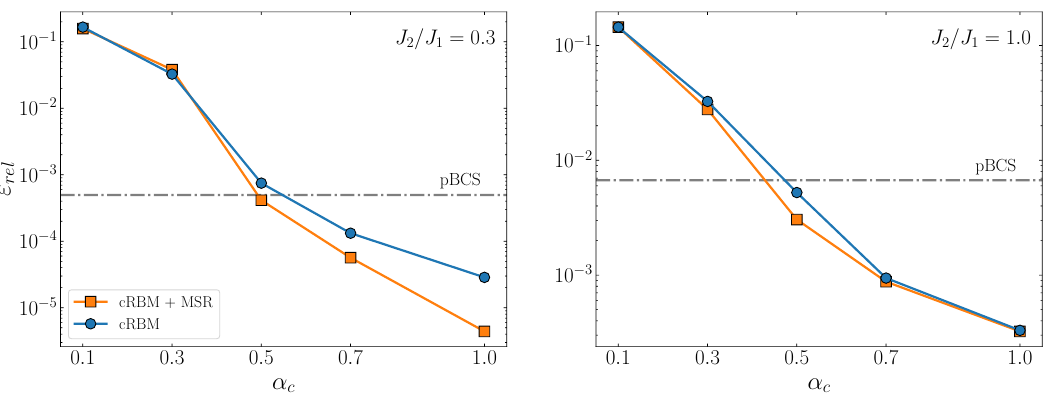
Figure 3: Accuracy of the variational energy for the J / J = 0.3 (left panel) and J N = 20 sites, for J 2 1 Ansatz of Eq. (4) is reported as a function of α cRBM wave function of Eq. (5) are reported for α real parameters (840) is the same as for the pmRBM state. The results obtained by including the Marshall-sign rule (MSR) are also shown. For J the accuracy of the cRBM with and without the Marshall-sign rule do not differ, thus we included only the former one in the plot. In both panels the results obtained by pBCS states are shown for comparison.